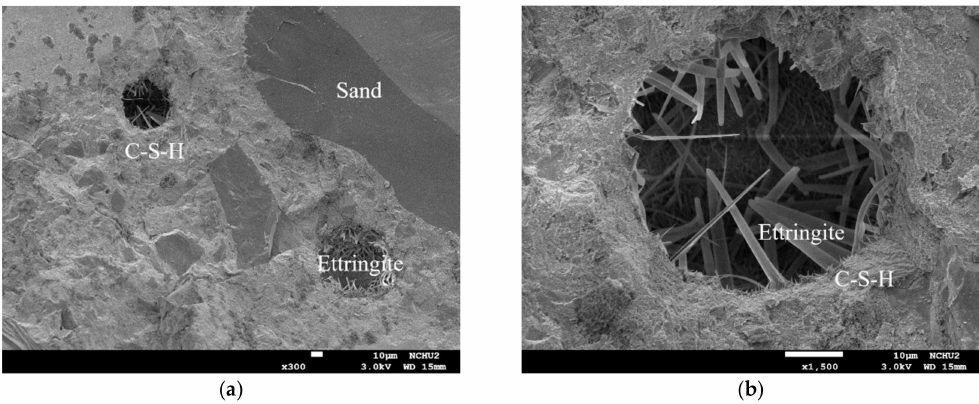
Figure 14. SEM observation after exposure to 500 ◦ C: ( a ) 300 × and ( b ) 1500 ×